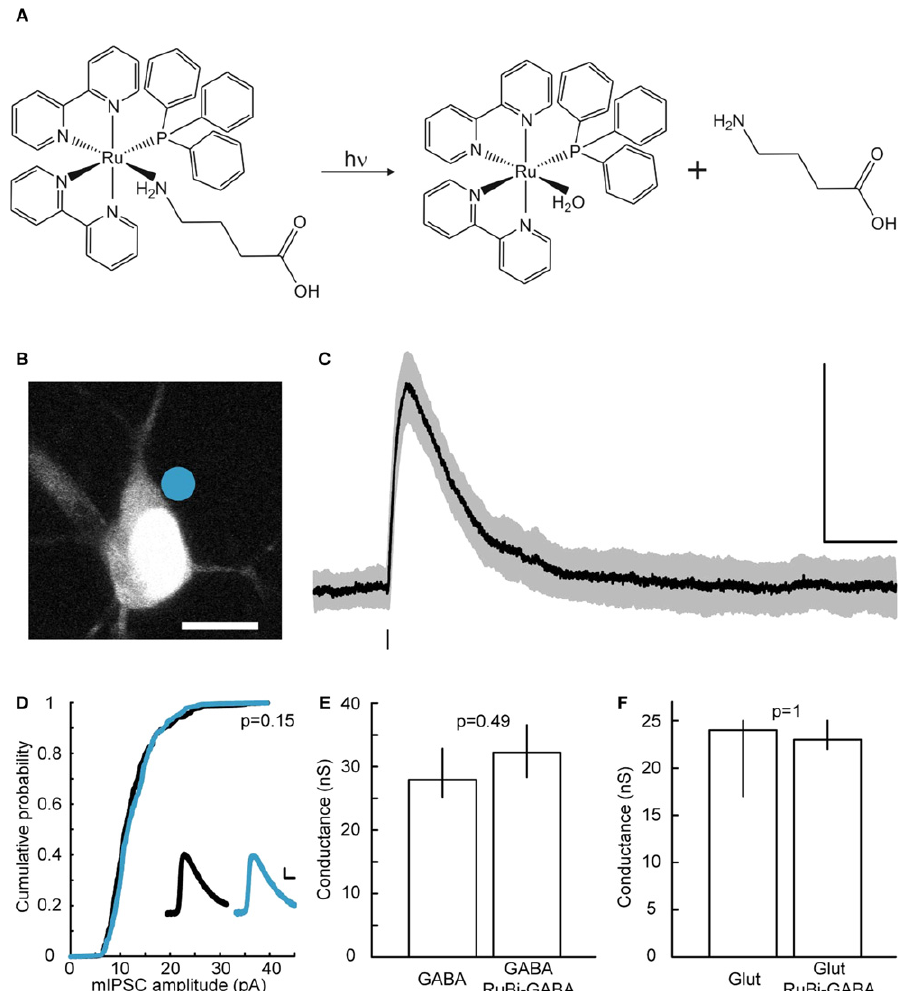
Figure 1 | RuBi-GABA uncaging-evoked outward currents without affecting endogenous conductances. (A) GABA photorelease from ruthenium- bipyridine-triphenylphosphine-GABA (RuBi-GABA). (B) Example of a typical uncaging experiment, with RuBi-GABA (5 μ M) in the perfusate, showing a cortical layer 2/3 pyramidal neuron loaded with Alexa Fluor 594. The cyan dot indicates the site of uncaging with 473 nm light. Scale bar: 10 μ m. (C) Average (black) and standard deviation (gray) of 50 successive uncaging responses. The black bar below the trace indicates the uncaging laser pulse. (D) Cumulative prob- ability plot of the amplitudes of 380 mIPSCs in the absence (black), and 326 mIPSCs in the presence of 20 μ M RuBi-GABA (cyan). Kolmogorov–Smirnov p -value is indicated. Inset: mIPSCs in the absence (black) and presence of 20 μ M RuBi-GABA (cyan). Scale bars: 2 pA, 10 ms. (E) Median and inter-quartile-range of conductances through the GABA-A receptors in response to GABA puffs (200 μ M) or GABA + RuBi-GABA (5 μ M). Mann–Whitney p -value is indicated ( n = 4). (F) Median and inter-quartile-range of conductances through glutamate receptors in response to glutamate puffs (200 μ M to 1 mM) or glutamate + RuBi-GABA (1.6 mM). Mann–Whitney p -value is indicated ( n =